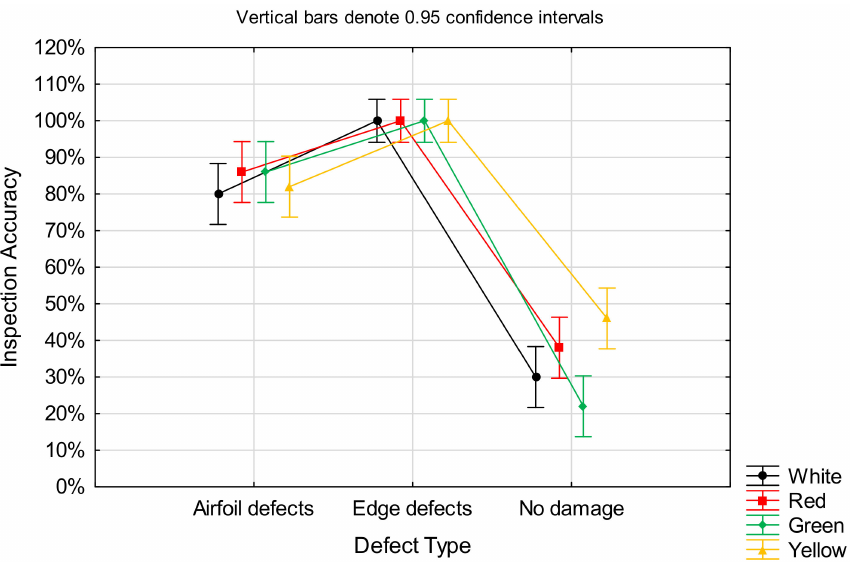
Figure 14. Effect of defect type on inspection accuracy for each background